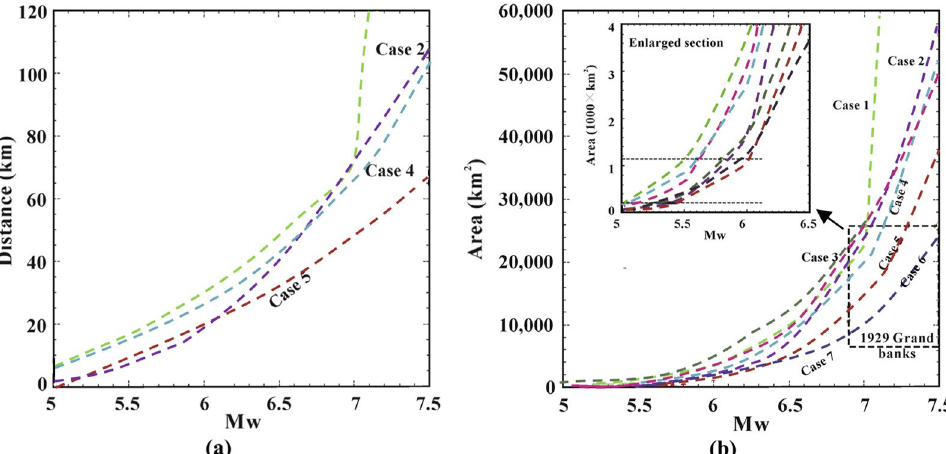
Fig. 17 The correlation between the earthquake magnitude and the scale of submarine landslides: a the correlation between the earthquake magnitude and the maximum distance to slope failure from fault rupture; b the correlation between the earthquake magnitude and the maximum area of slope failure (modified from Uri et al.